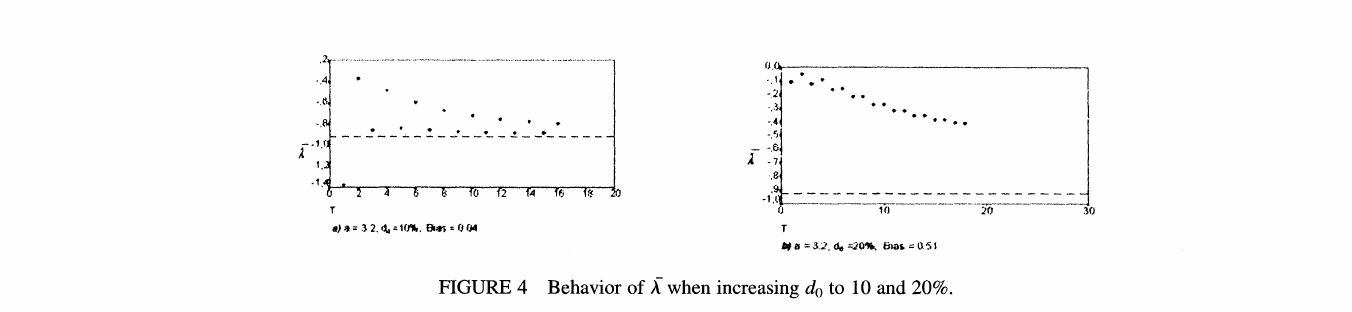
FIGURE 4 Behavior of X when increasing do to 10 and 20%.